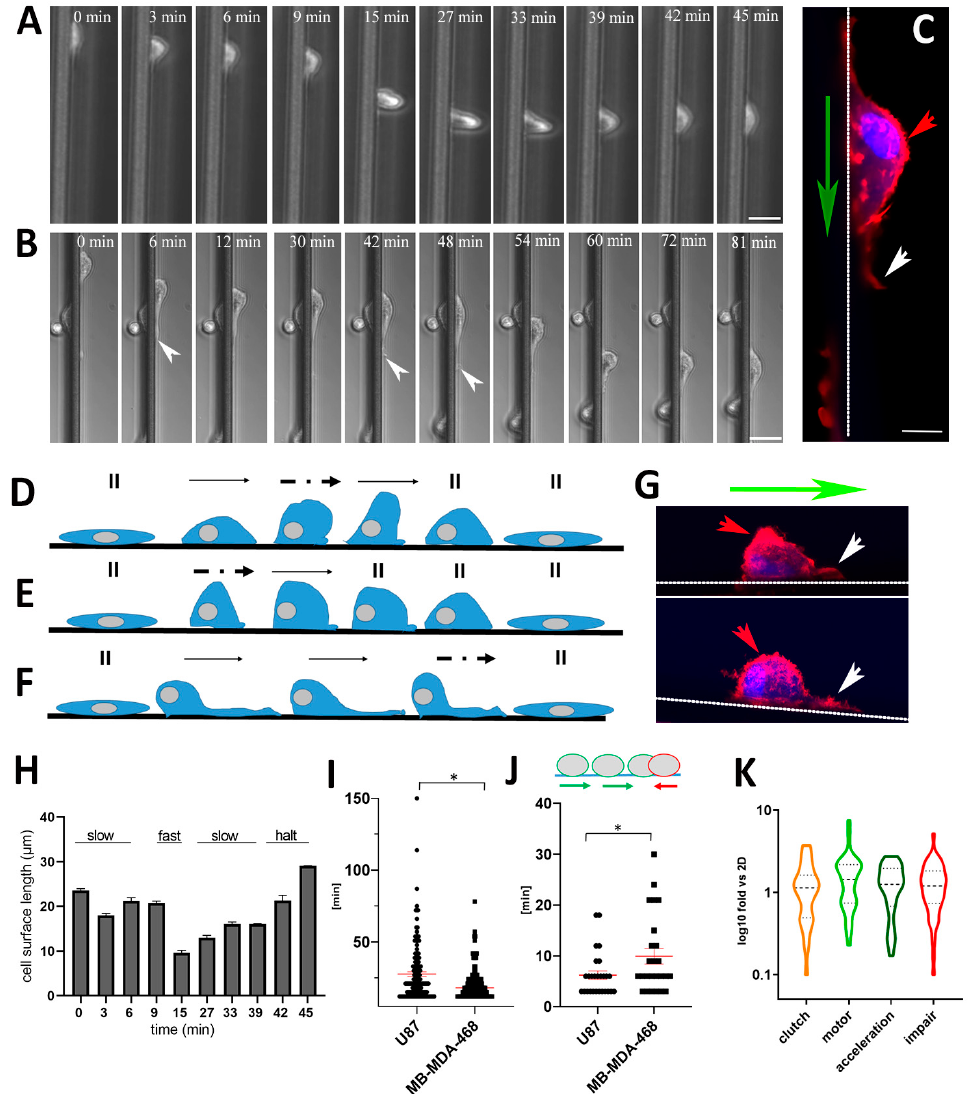
Figure 8. Skating snail-like cellular plasticity modes and persistence on aligned microfibers. ( A , B ) Consecutive images of U87 cell plasticity modes and migration over time; white arrows indicate leading edge cellular protrusions (scale bar = 25 µ m). ( C ) Confocal image of z-stacks showing F-actin Red staining of an amoeboid U87 PTEN loss of function cell (red: F-actin, blue DRAQ5 indicates nuclei), red arrow indicates cell nucleus at cell rear, white arrow indicates leading edge cellular protrusion, green arrow indicates direction of movement (scale bar = 10 µ m). ( D – F ) Schematic images of migration cell plasticity modes of “skating snail-like” movements for U87 cells. II = nonmoving resting cells; thin arrow = slow cell movement; bold dotted-thick arrow = fast cell movement ( G ) Confocal image of z-stacks of two U87 cells (top, bottom) (red: F-actin, blue DRAQ5 indicates nuclei), red arrow indicates strong F-actin stain around the cell circumference, white arrow indicates cellular protrusion, and green arrow indicates direction of movement. ( H ) Quantification of cell surface length on aligned microfibers (Y-axis) of different U87 migration modes (X-axis). Shortest bar graph = fastest mode of movement. ( I ) Quantification of total U87 and MDA-MB-468 cell migration time (min) for single cell movements along aligned microfibers, FigU87: 27.06 ± 1.65 min; MDA-MB-468: 21.08 ± 1.09 min; * p = 0.0142. ( J ) Quantification of reverse migration (min) of single movements of U87 and MDA-MB-468 after continual forward movements (green circle and arrow = forward movement and red circle and arrow = reverse movement), U87: 6.22 ± 0.83 min, MDA-MB-468: 9.96 ± 1.53 min; * p = 0.0462. A total of 258 single cell movements were analyzed for both 8I and 8J. ( K ) RNA-seq gene expression differences of U87 cells in 3D with Matrigel and scaffolds versus U87 in 2D. Expression of clutch genes ( n = 35), motor genes ( n = 40), acceleration genes ( n = 50) and migration impairment genes ( n = 58) [60–62].